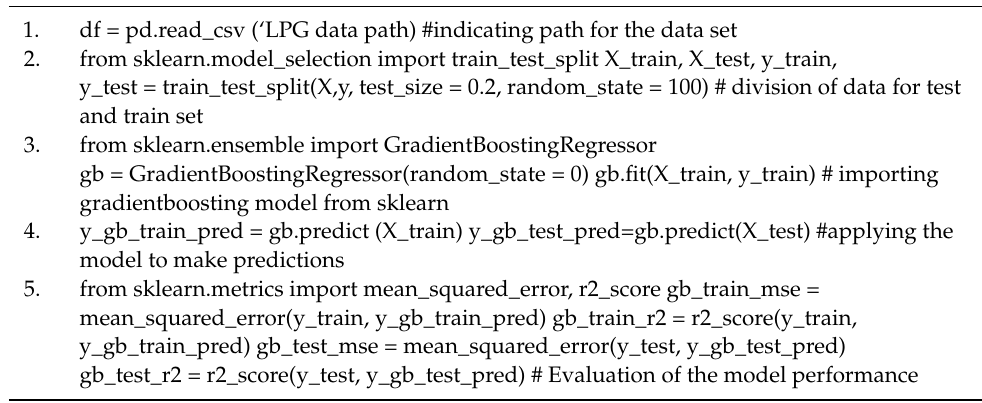
Algorithm 1. LPG vehicle emission model in Python; selected